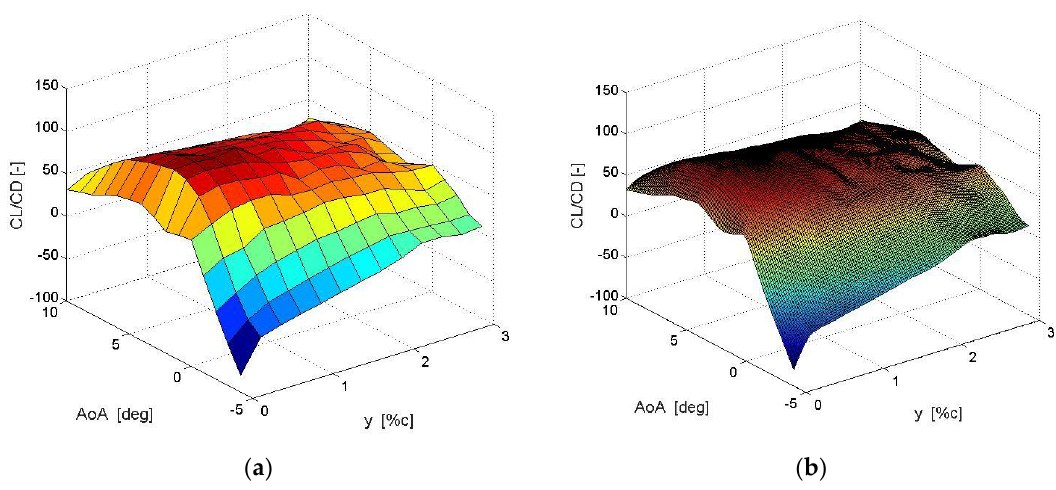
Figure 7. Lift-to-drag ratio surfaces. ( a ) CFD results and ( b ) recursive POD approximation results.